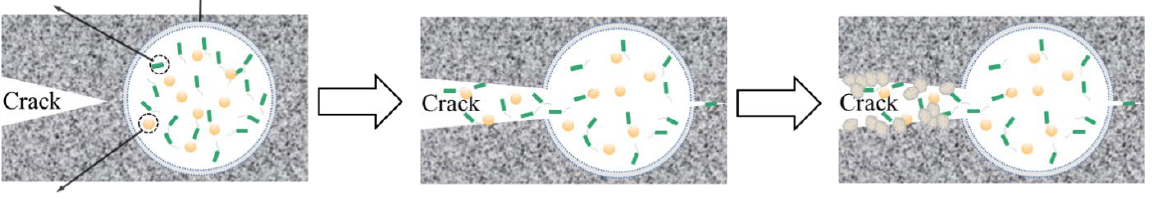
Figure 5. Schematic diagram of the self-healing process of microcapsules.